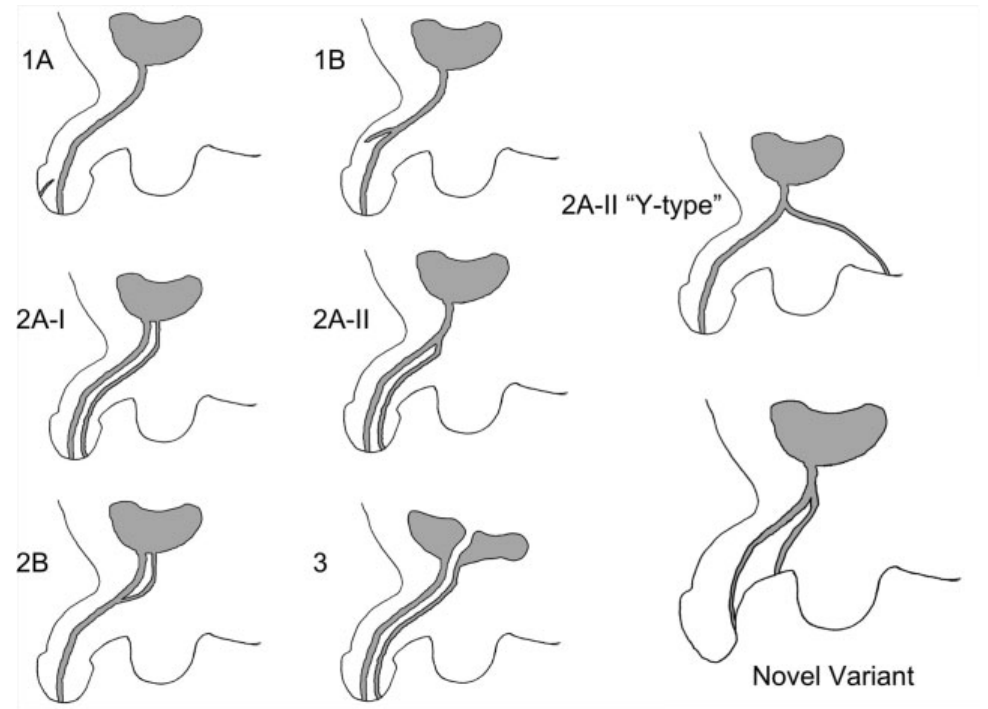
Fig. 1 Effman classi fi cation of urethral duplication with described ‘ novel ’ variant (adapted from Effman et al 2 ). (cid:129) Type 1: ‘ Blind ending channels ’ or incomplete duplication (cid:1) Type 1A: A blind ending channel opening on the dorsal or ventral surface of the penis in the midline, without communicating with either the bladder or urethra. (cid:1) Type 1B: A blind ending channel originating from the urethra. (cid:129) Type 2: Patent and